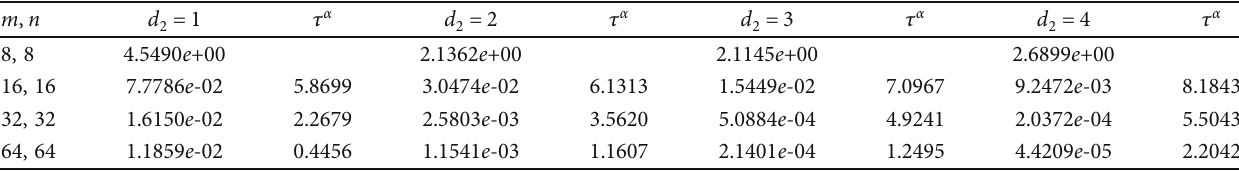
= 7 at t = 1 for Chebyshev 1